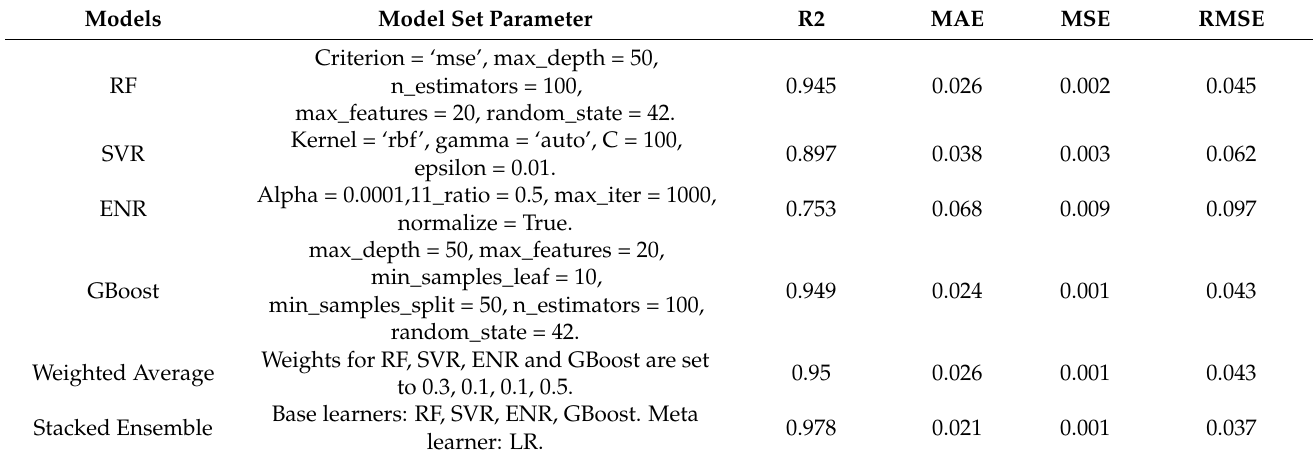
Table 7. Comparison of Models for Asthma Prediction (created by author).